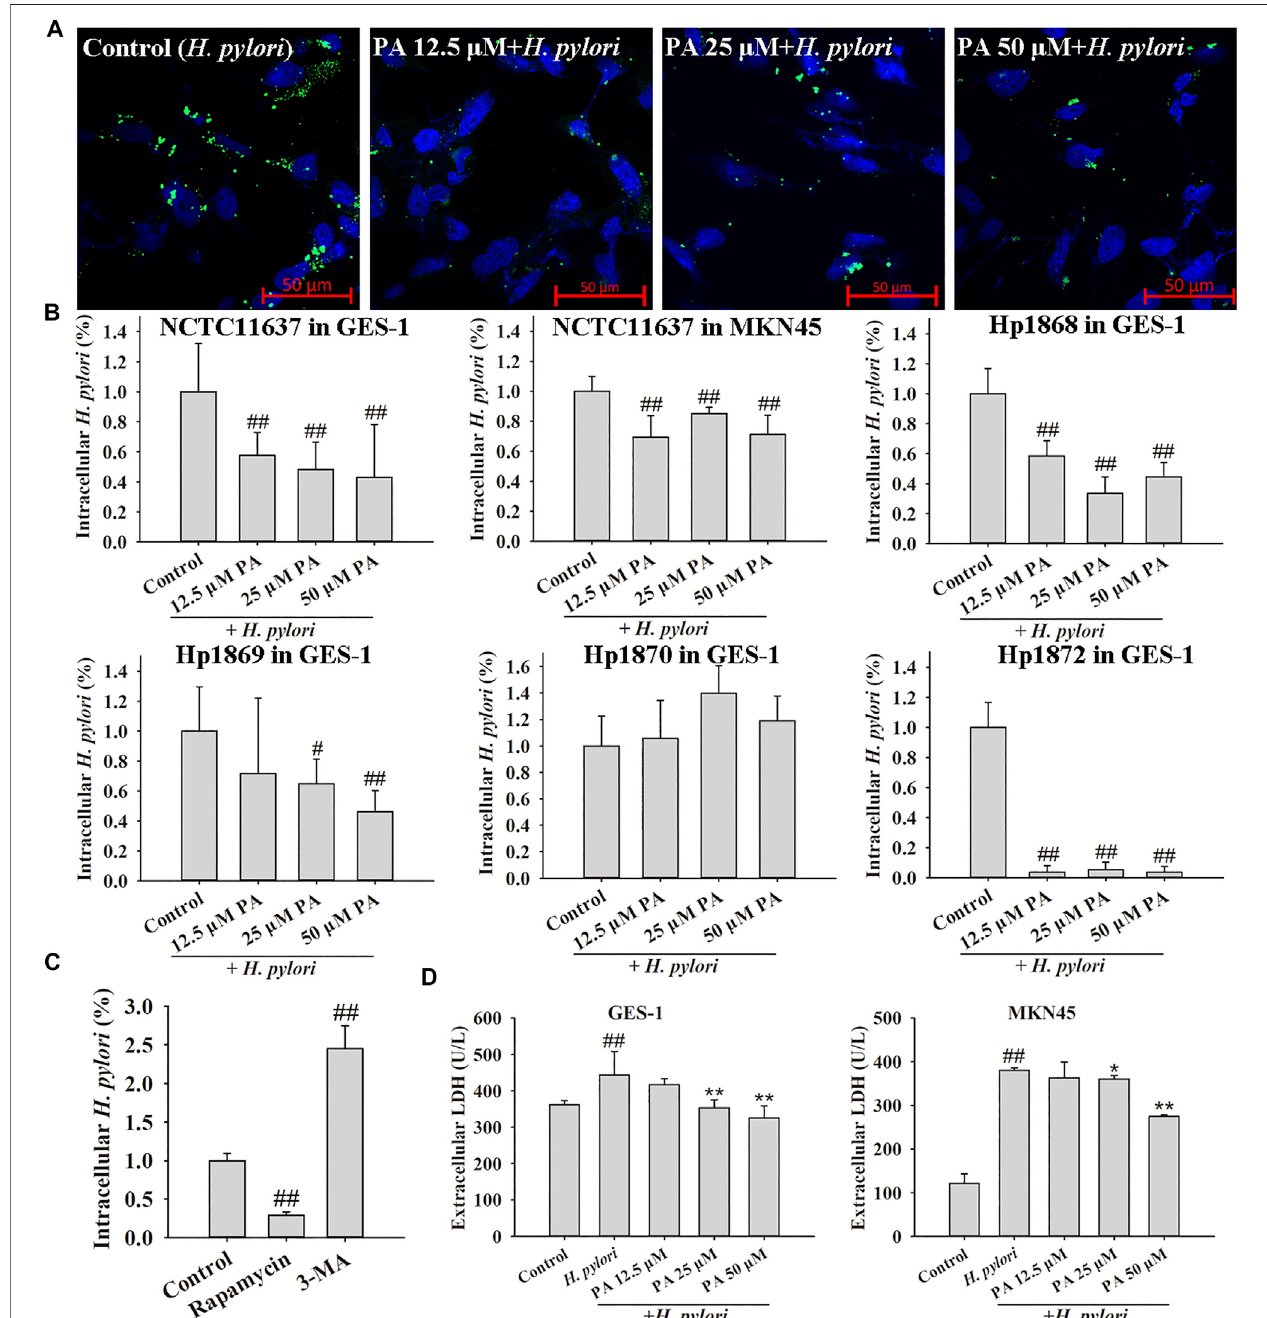
FIGURE 3 | Effects of PA, an autophagy agonist (rapamycin), and an autophagy inhibitor (3-MA) on intracellular H. pylori survival. (A) Representative confocal images of intracellular H. pylori treated with PA. (B) . Effects of PA on the intracellular H. pylori strains NCTC11637, Hp 1868, Hp 1869, Hp 1870, and Hp 1872. The control group includes cells infected with H. pylori without treatment ( n (cid:2) 6). (C) Rapamycin reduced the number of intracellular H. pylori NCTC11637 whereas 3-MA increasedtheintracellularnumberof H.pylori NCTC11637inGES-1cells.Thecontrolgroupincludescellsinfectedwith H.pylori withouttreatment( n (cid:2) 3). (D) LDH release from GES-1 and MKN45 cells increased following H. pylori infection. PA (25 and 50 μ M) protected these cells from H. pylori infection ( n (cid:2) 6). # p < 0.05, ## p < 0.01, compared with the control group. * p < 0.05, ** p < 0.01, compared with the H. pylori